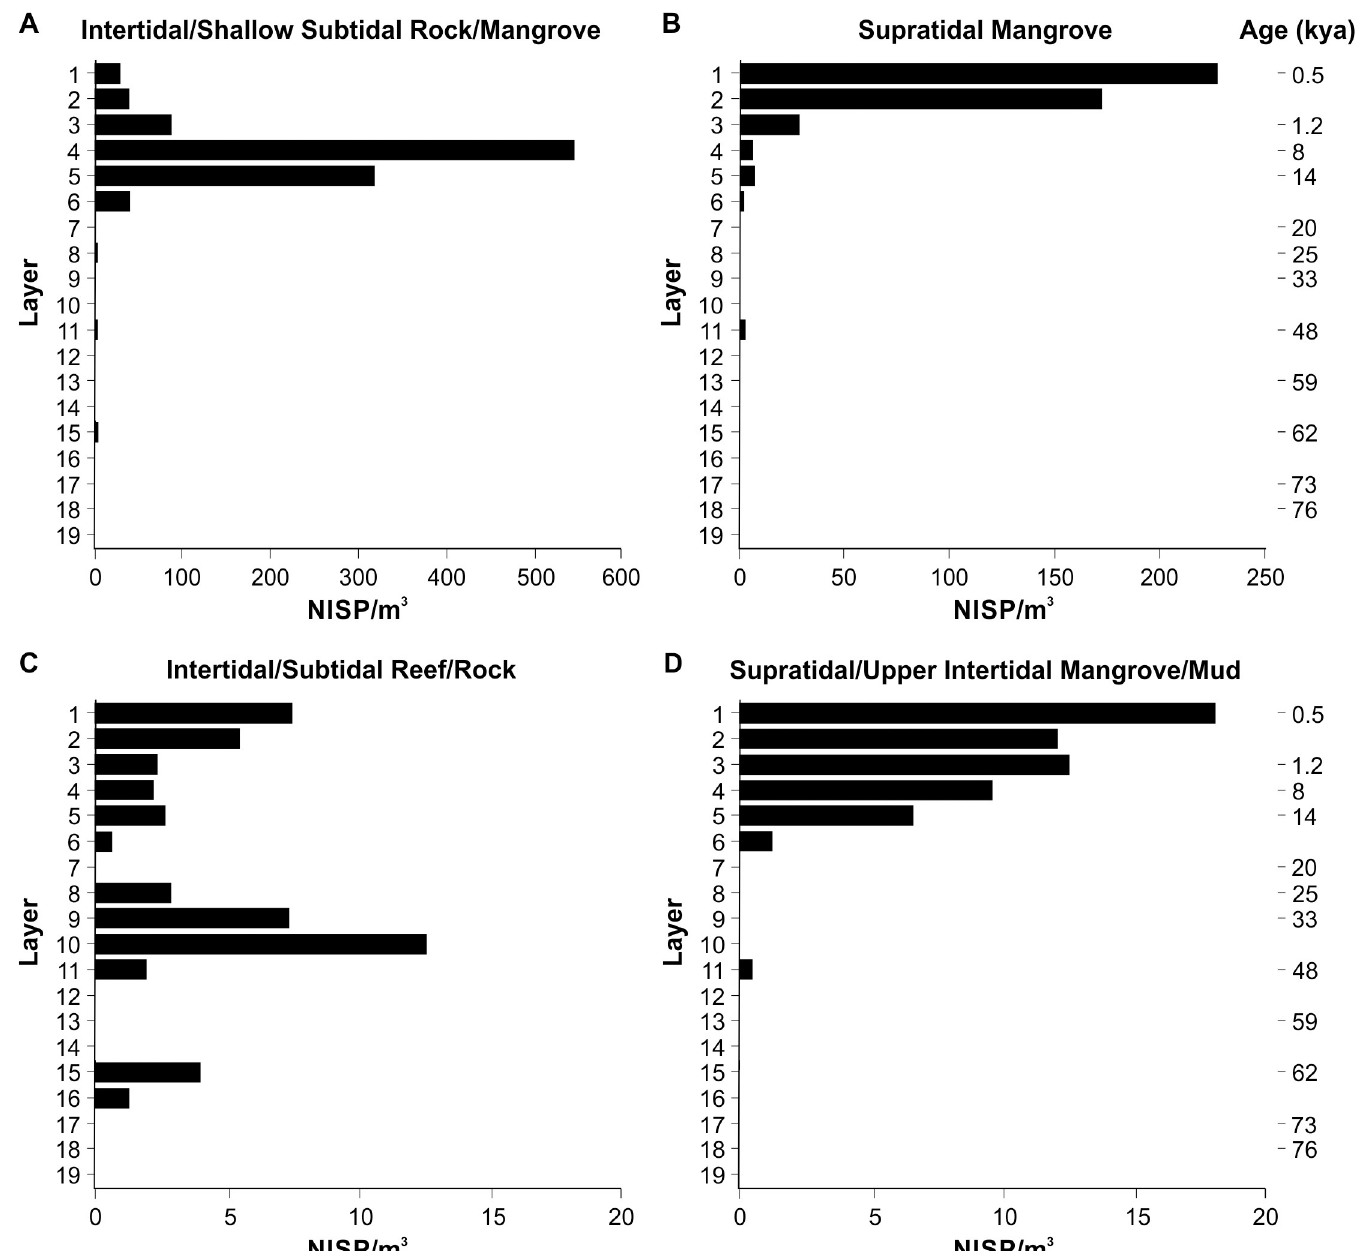
Fig 10. Distribution (NISP/m 3 ) through the PYS sequence by Layer of taxa from broadly defined habitat zones. Intertidal/shallow subtidal rock/mangrove (A), supratidal mangrove (B), intertidal/subtidal reef/rock (C) and supratidal/upper intertidal mangrove mud (D). Note differences in horizontal